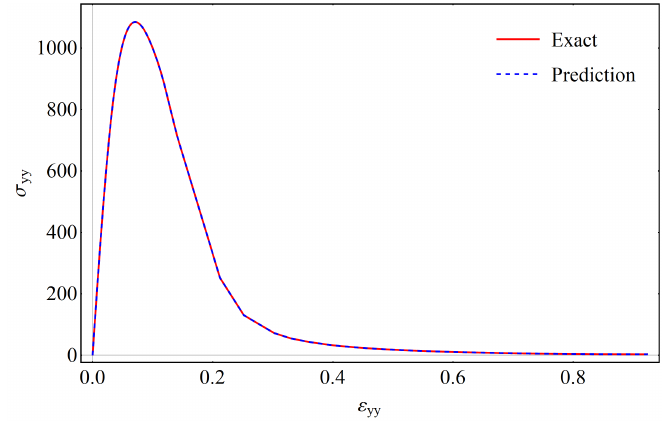
Figure 11. Single-edge notched test (SENT). Validation of stress–strain behavior with NN formulation against FE formulation. The stress unit is [N/mm 2 ].